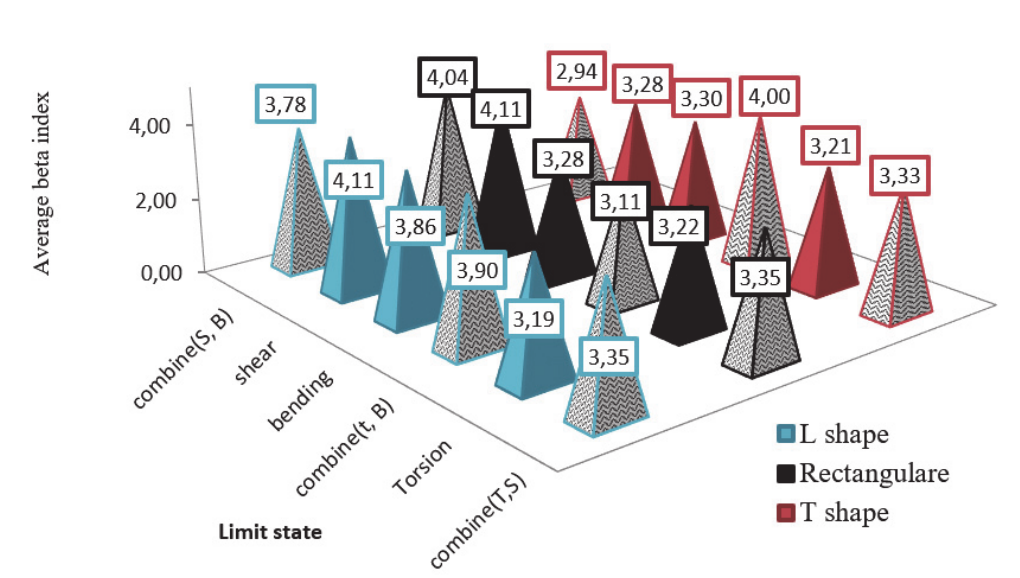
Figure 12: Maximum ACI beta indexes for different